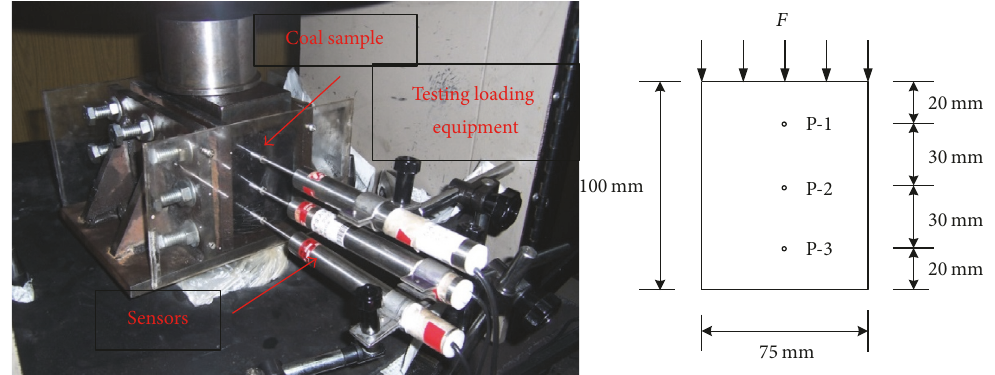
Figure 7: Arrangement of the measuring points.